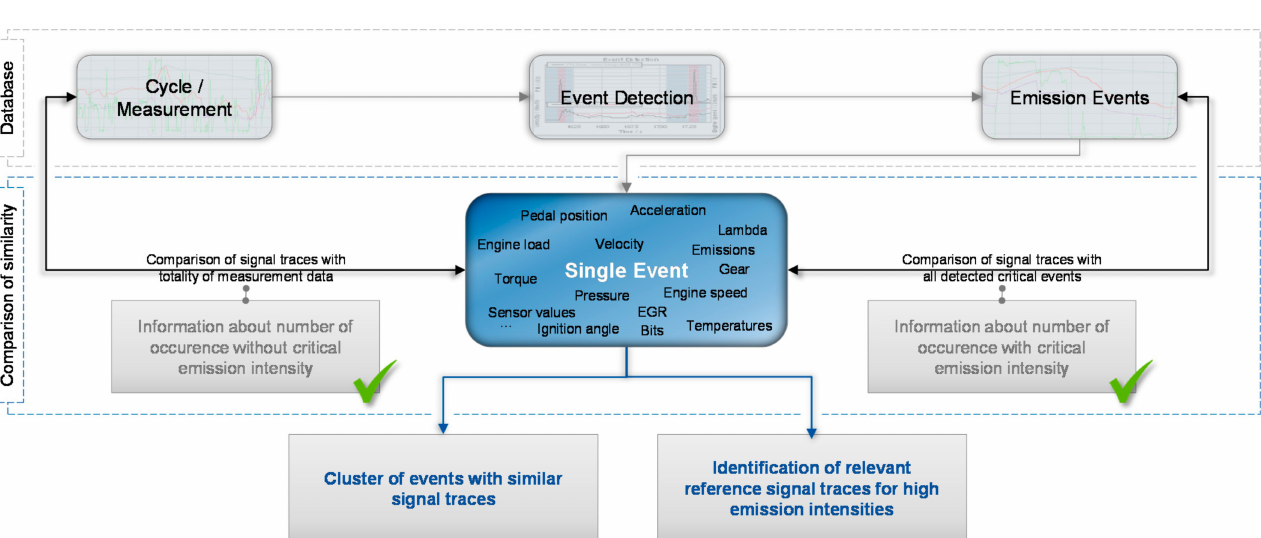
only one signal is considered and thus no averaging over multiple signals is